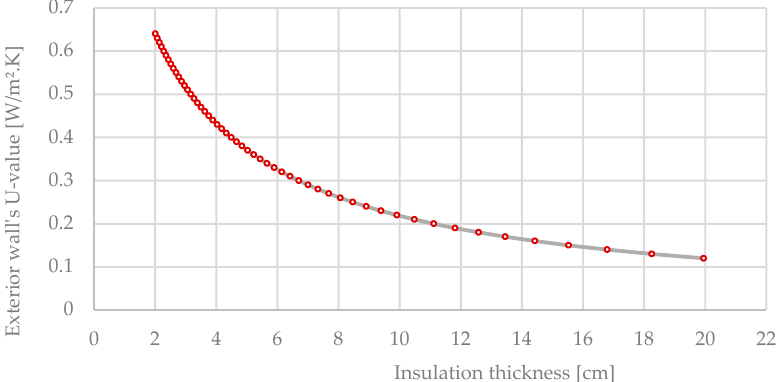
Figure 7. External-wall insulation thickness and related U-value.